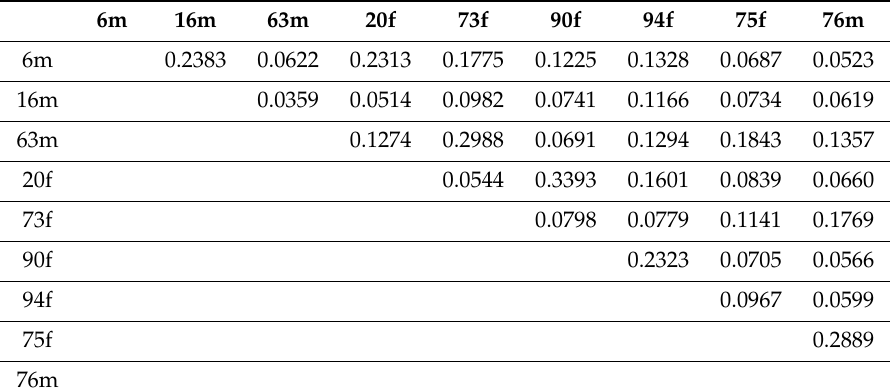
Table 3. Proximity matrix (mean = 0.125; SD =